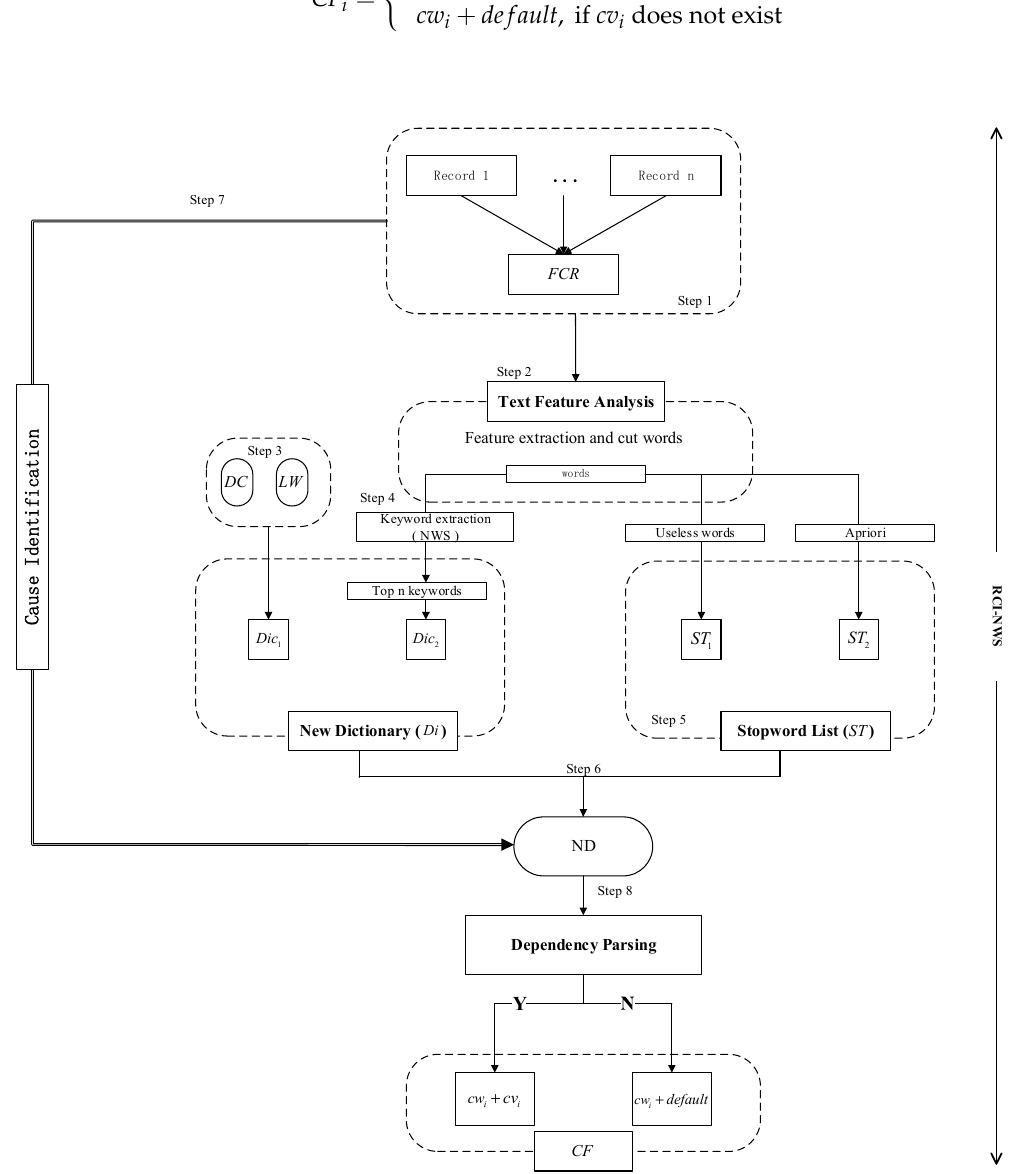
Figure 4. Framework of proposed method.